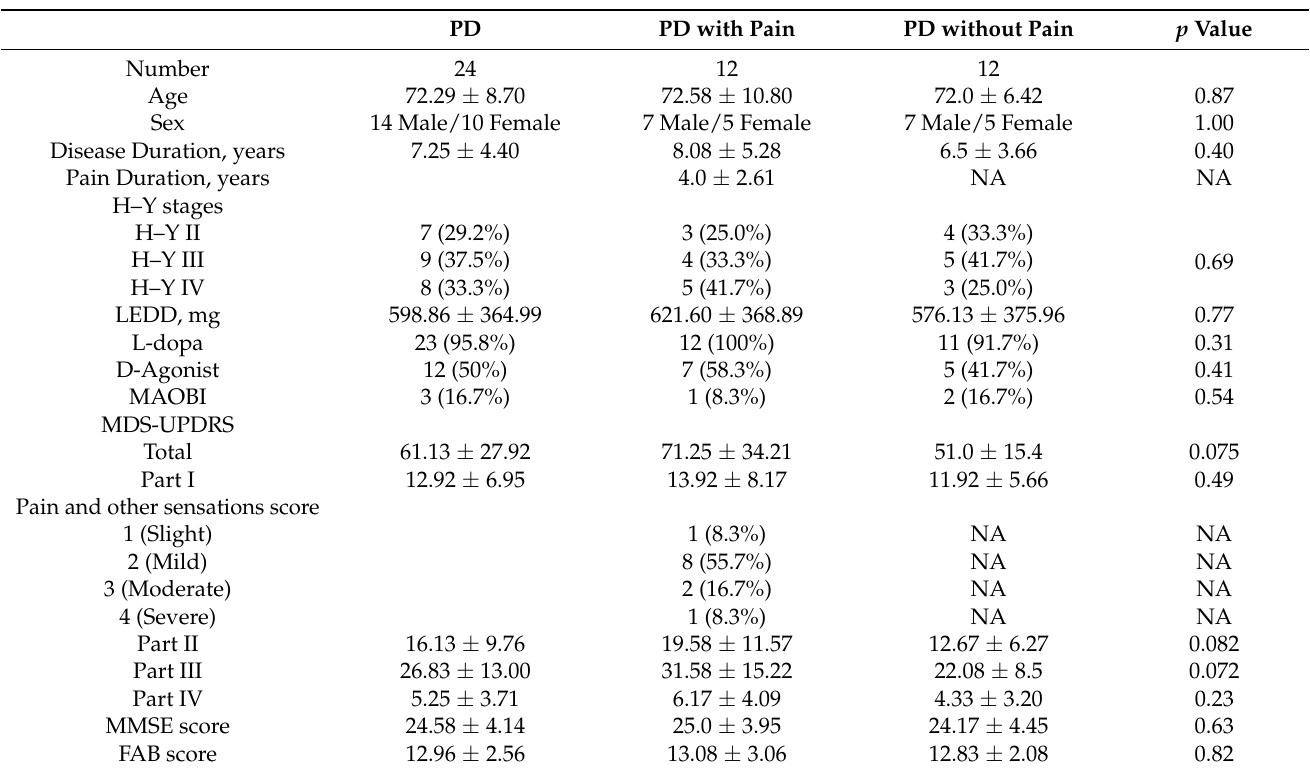
Table 1. Demographic and clinical characteristics of the